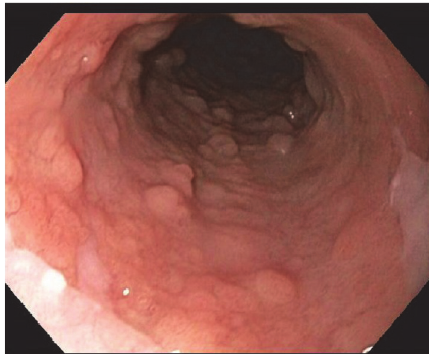
Figure 2: Patient 1 (white light endoscopy). Esophagus after multi- ple hot snare polypectomies, prior to RFA.